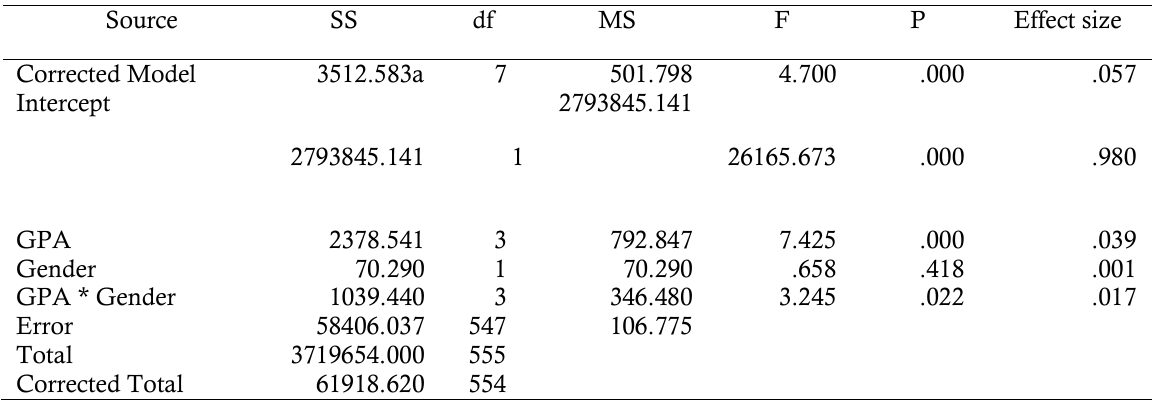
Table 7. Univariate Analysis of the effect of gender, grade and GPA on CDMSE .